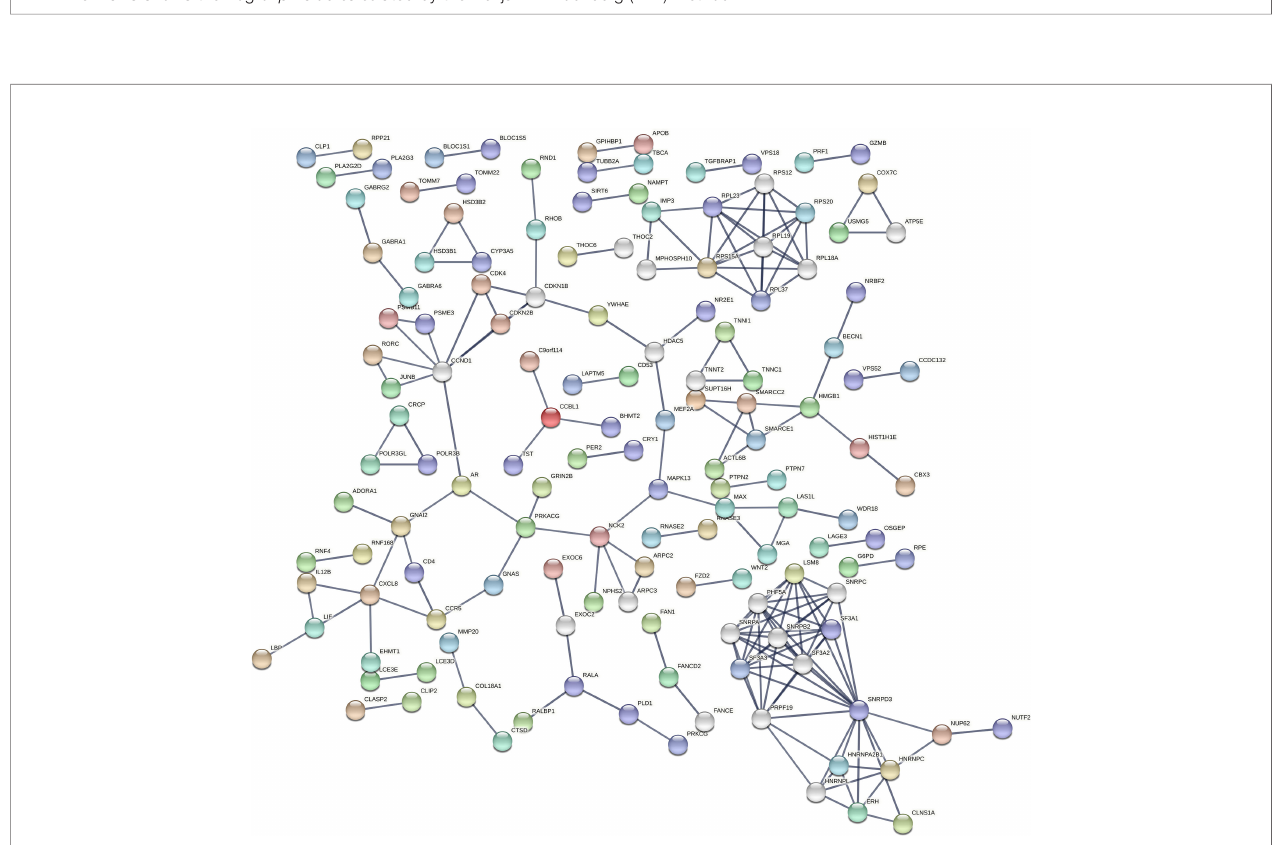
FIGURE 3 | Protein-protein interaction (PPI) network of DE miRNA ’ s targeted genes by STRING. STRING is a database of known and predicted protein-protein interactions, including physical and functional associations based on text mining of the scienti fi c literature, other databases, computational predictions, and knowledge transfer between organisms. The network gives information on the degree of overall connectivity across imputed genes. The interaction score was set to the highest con fi dence (0.9), showing a high probability of the association being true.